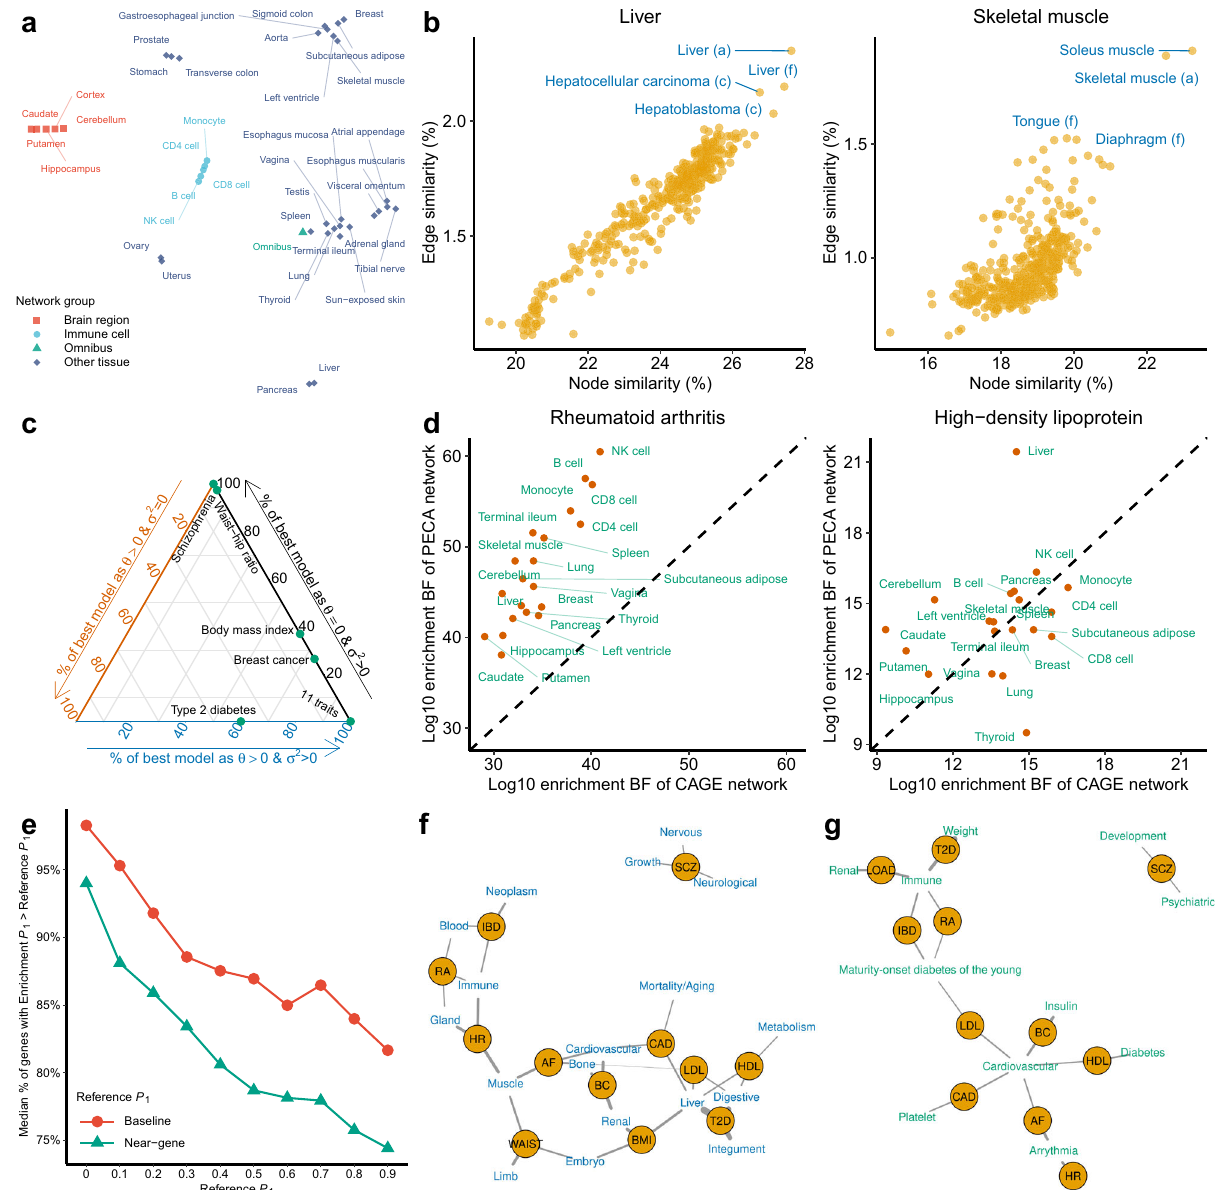
Fig. 5 RSS-NET analyses of 18 complex traits and 38 regulatory networks. a Clustering of 38 regulatory networks based on t -distributed stochastic neighbour embedding. Details are provided in Supplementary Fig. 11. b Similarity between a given tissue-speci fi c PECA-based network and 394 CAGE- based networks for various cell types and tissues (a: adult samples; c: cell lines; f: fetal samples). The similarity between a PECA- and CAGE-based network is summarized by Jaccard indices of their node sets ( x -axis) and edge sets ( y -axis). To simplify visualization, only labels of top four CAGE-based networks with the highest edge similarity are shown for each PECA-based network. See Supplementary Fig. 12 for additional results. c Ternary diagram showing, for each trait, percentages of the “ best ” enrichment model (with the largest BF) as M 11 : θ > 0, σ 2 = 0, M 12 : θ = 0, σ 2 > 0 and M 13 : θ > 0, σ 2 > 0 across networks. See Supplementary Table 4 for numerical values. Shown are 16 traits having multiple networks more enriched than the near-gene control. d Comparison of context-matched PECA-based ( y -axis) and CAGE-based ( x -axis) network enrichments on the same GWAS. Dashed lines have slope 1 and intercept 0. See Supplementary Fig. 14 for additional results. e Median proportion of genes with P bma higher than reference estimates ( P base or P near ), among genes with 1 1 1 reference estimates higher than a given cutoff. Medians are evaluated among 16 traits in c . See Supplementary Table 5 for numerical values. Overlap of RSS-NET prioritized genes ( P bma (cid:5) 0 : 9) with genes implicated in f knockout mouse phenotypes 47 and g human Mendelian diseases 49,50 . An edge 1 indicates that a category of knockout mouse or Mendelian genes is signi fi cantly enriched for genes prioritized for a GWAS trait (FDR ≤ 0.1). Thicker edges correspond to stronger enrichments. To simplify visualization, only top-ranked categories are shown for each trait ( f 3; g 2). See Supplementary Data 4, 5 for full results. Trait abbreviations are de fi ned in Supplementary Table